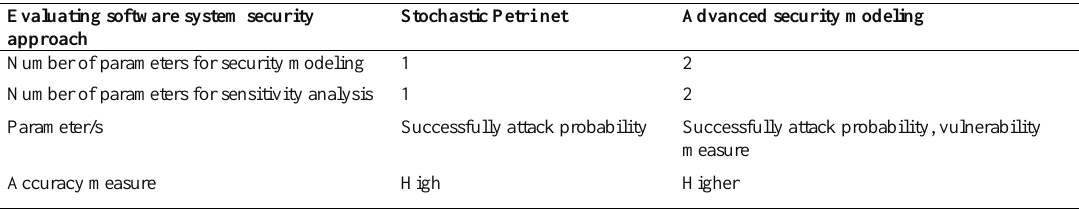
Table 2. Advanced modeling and prediction with SPN vs. modeling and prediction suggested by